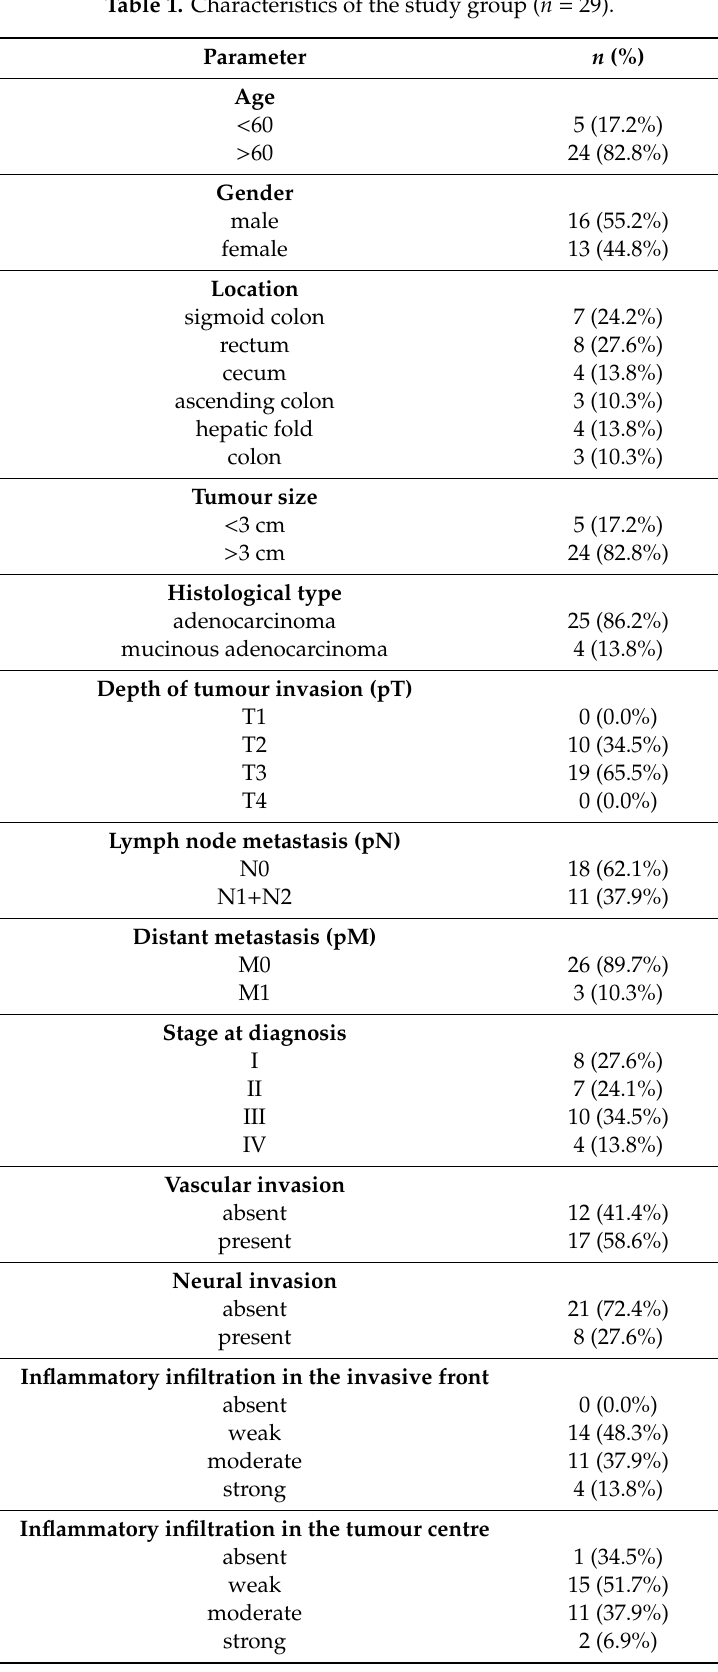
Table 1. Characteristics of the study group ( n =